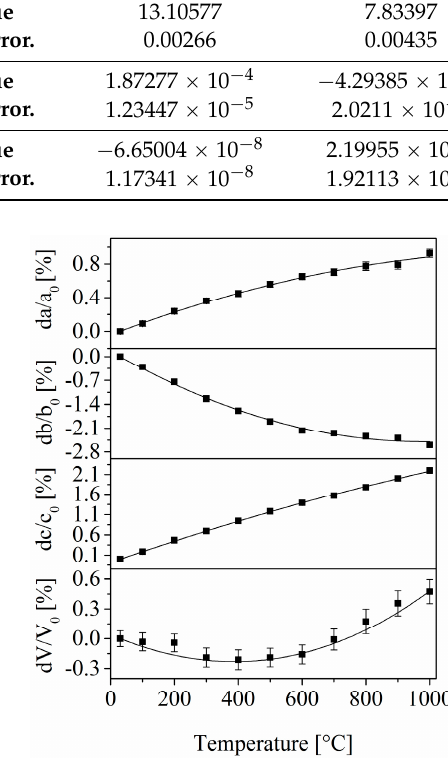
Figure 2. Relative change of the lattice parameters of Ba 0.5 Sr 0.5 Zn 2 SiGeO 7 determined with HT ‐ XRD. The values a 0 , b 0 , c 0 , and V 0 were determined at room temperature. The line, which fits the change of the volume of the unit cell was calculated on the basis of the regression parameters given in Table 1.